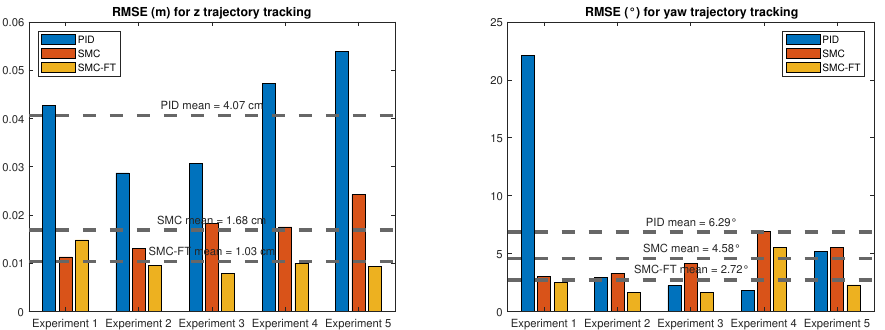
Figure 17. RMSE comparison for the trajectory tracking with the different controllers. ( Left ) Depth. ( Right )